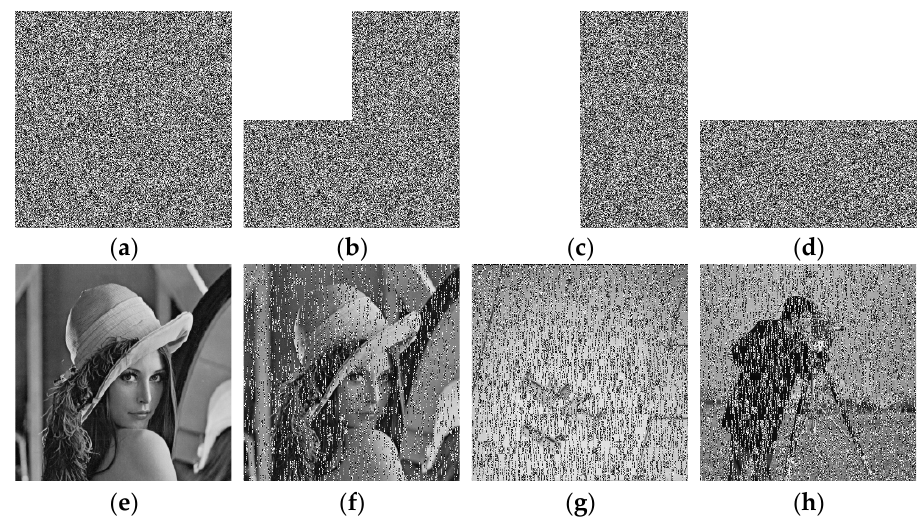
Figure 11. Analysis of the data loss attack: ( a ) 0% data loss in the encrypted image of Lena; ( b ) 25% data loss in the encrypted image of Lena; ( c ) 50% data loss in the encrypted image of the airplane; ( d ) 50% data loss in the encrypted cameraman image; ( e ) decrypted Lena image from the image drawn in ( a ); ( f ) decrypted Lena image from the image drawn in ( b ); ( g ) decrypted airplane image from the image drawn in ( c ); ( h ) decrypted cameraman image from the image drawn in ( d ).